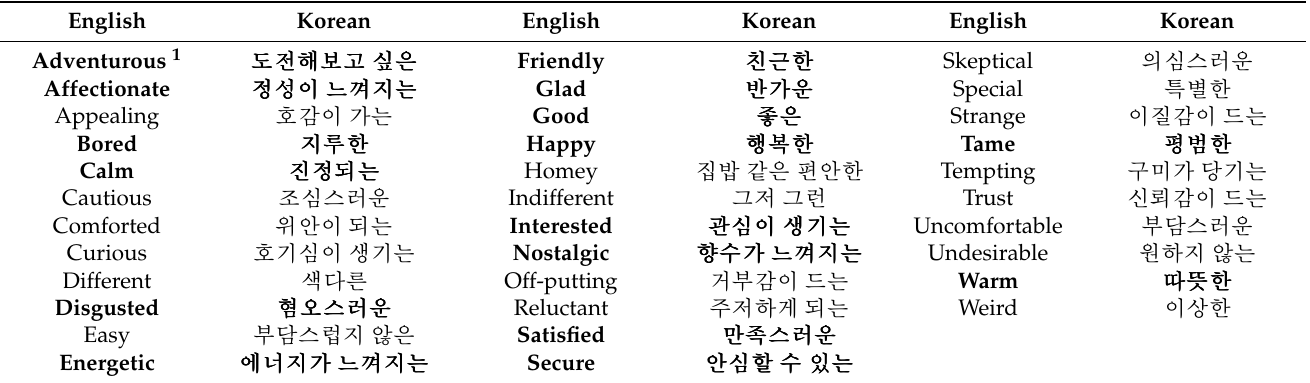
Table 3. Developed emotion